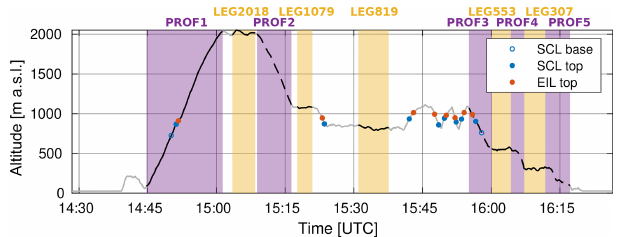
Figure 2. ACTOS altitude in flight no. 5 with marked selected pro- files and horizontal legs. PROFs are ordered chronologically; LEGs are ordered according to their altitude. Line styles of the PROFs are consistent with the figures in the following sections. Altitude ranges corresponding to PROF2–PROF5 of this flight do not overlap and are all marked with dashed lines. Dots indicate the penetrations of the boundaries of the specific sublayers described in Sect.